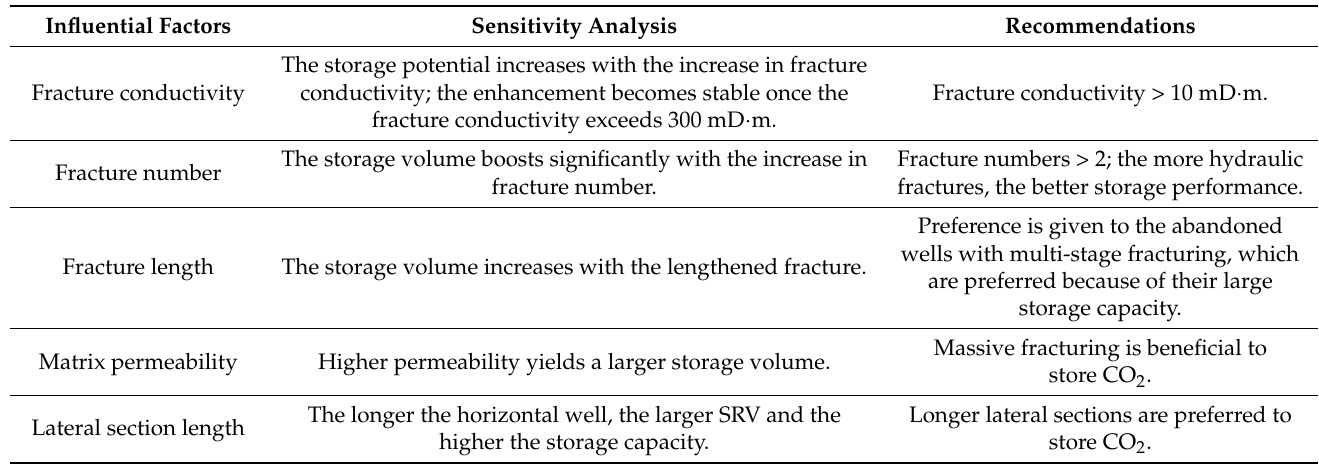
Table 2. Impact of engineering factors on storage [77].